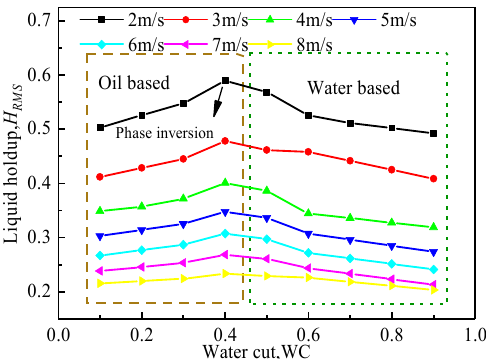
Figure 6. H RSM variation with WC at J L = 1.5 m/s, J g = 2.0–8.0 m/s. The liquid velocity variations with WC for J L = 1.5m/s and J g = 2.0–8.0 m/s are shown in Figure 7. It can be seen that the liquid velocity u RSM decreases first and then increases with the increase in WC and that it reaches the minimum in the phase inversion region. This trend is opposed to that of the liquid holdup. In the oil-based slug flow regime, the effective viscosity increases with the increase in WC, which leads to the decrease in liquid velocity. However, the opposite trend occurs in the water-based slug flow regime. This also means that in the water-based slug flow regime, the water phase acts as a lubricant that reduces the viscous force between the liquid and the wall.